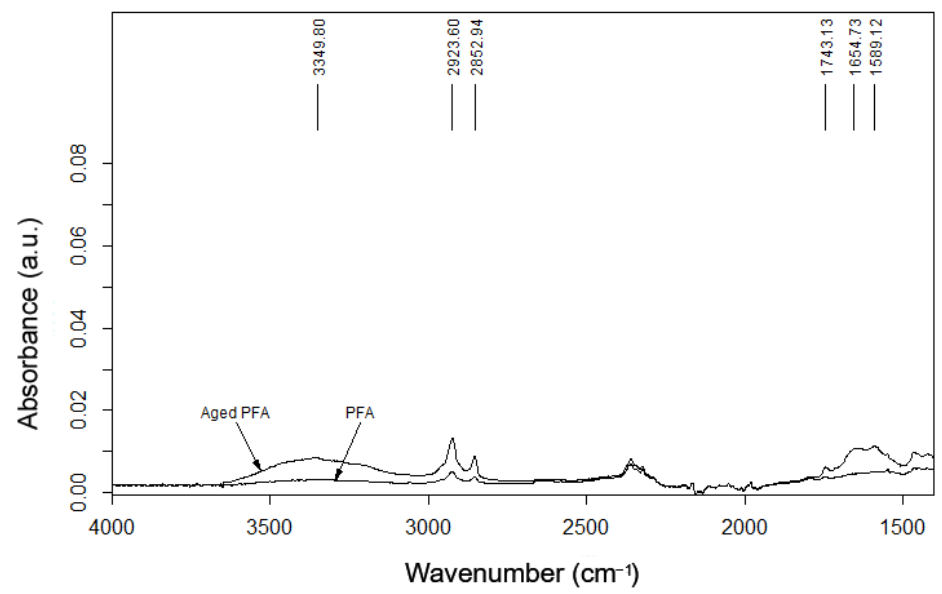
Figure 14. The 4000–1400 cm − 1 range of the spectrum relating to unaged and aged Figure 14. The 4000 – 1400 cm − 1 range of the spectrum relating to unaged and aged PFAs.